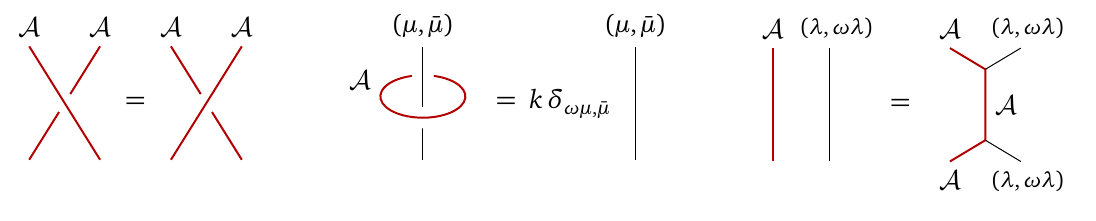
Figure 1: Basic properties of the Abelian Lagrangian algebra object A